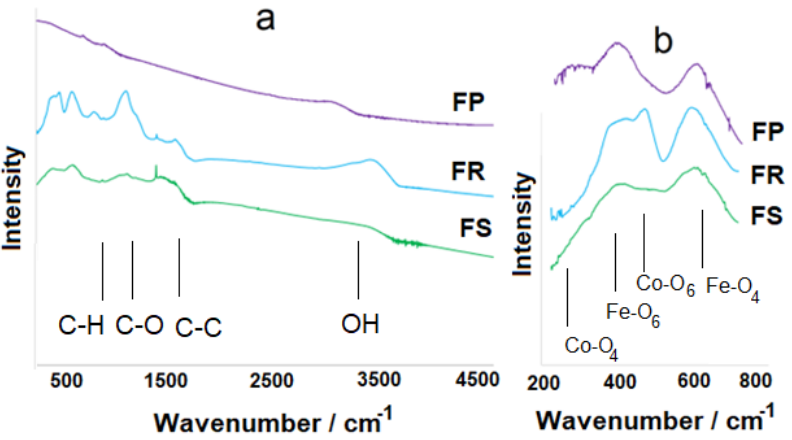
Figure 4. FTIR spectra for the synthesized composite materials ( a ) with detailing of the oscillation region for the oxide component ( b ).